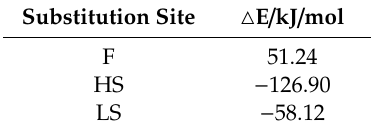
Table 1. Impurity substitution energy of the pyrite surface substituted by carbon atoms on different sites.